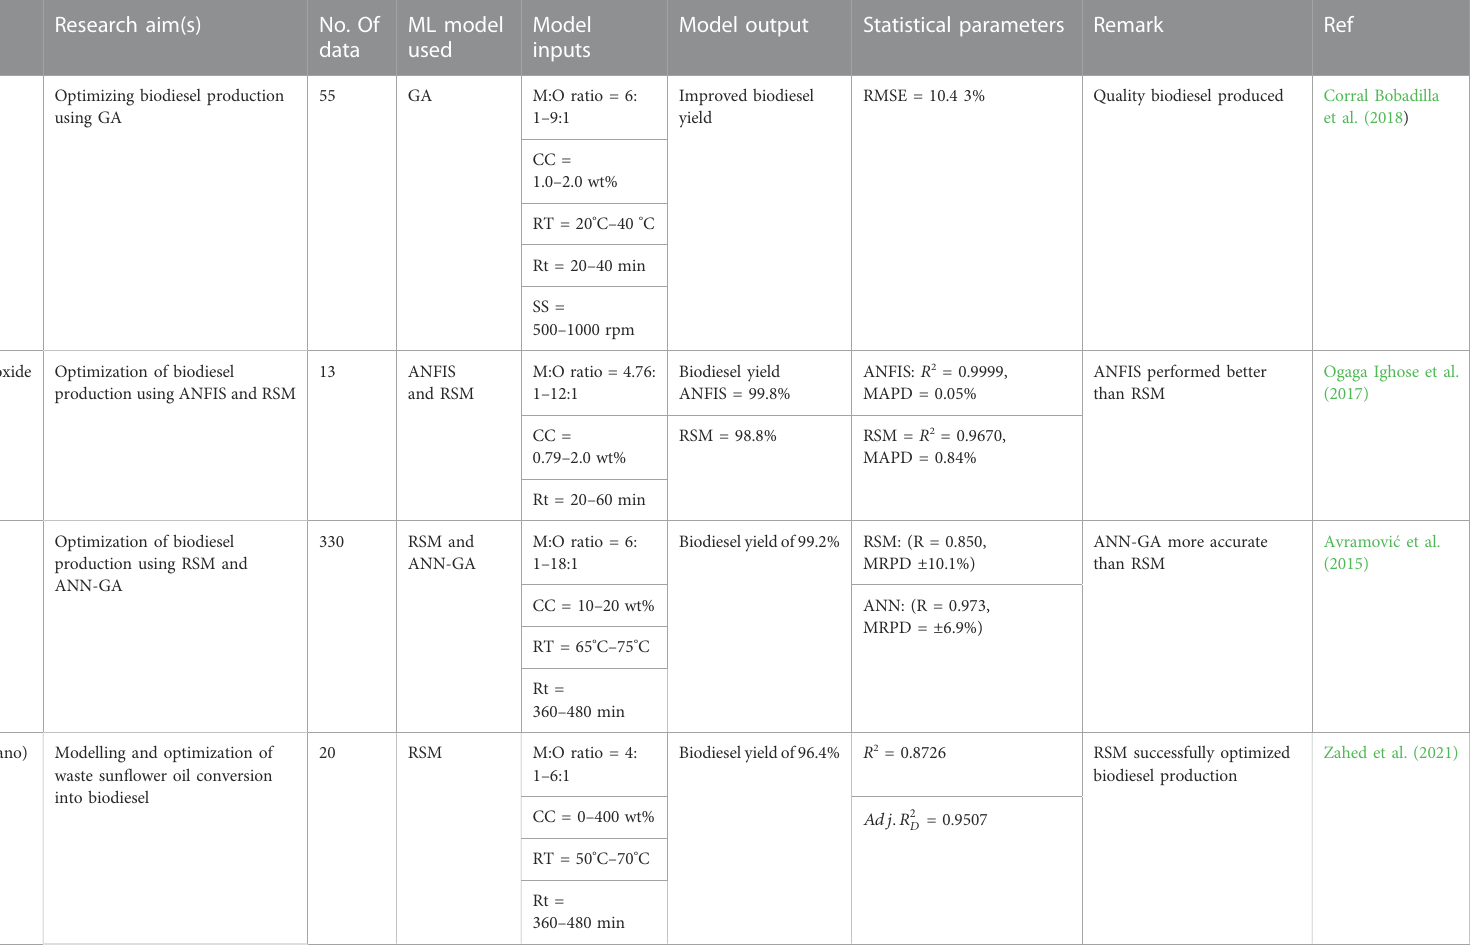
TABLE 6 ( Continued ) Application of ML models for modelling, predicting, and optimizing biodiesel process